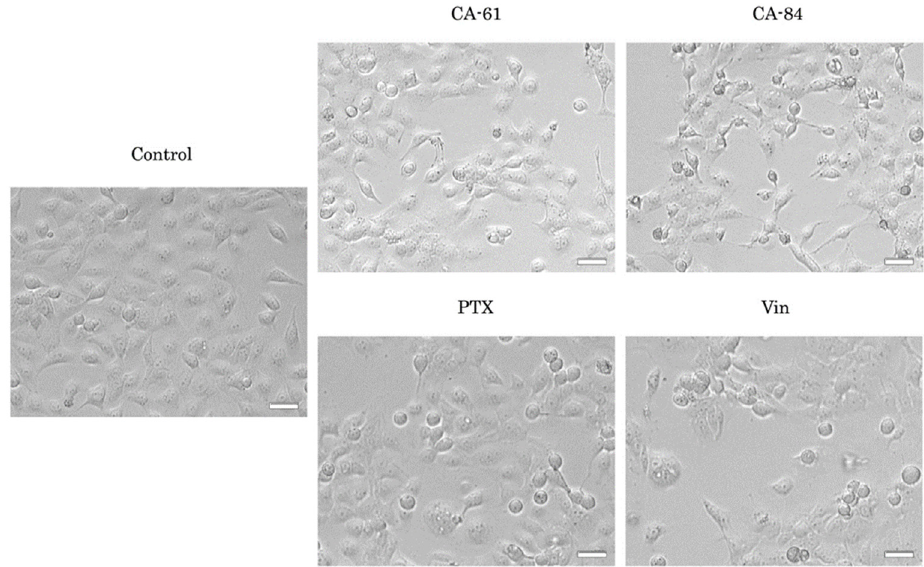
Figure 5. CAs induce changes in the morphology of cancer cells. Morphological changes in HCC1806 breast cancer cells treated with solvent (DMSO) (negative control), CA-61 and -84 (10 μ M), Paclitaxel (PTX) (0.5 μ M), and Vinblastine (Vin) (0.1 μ M). The chemotherapeutic agents were used as a positive control. Cells were treated with CAs and chemotherapeutic agents (indicated above) for 9 h and subjected to light microscopy (Leica). Magnification 10×, scale bars 100 μ M.